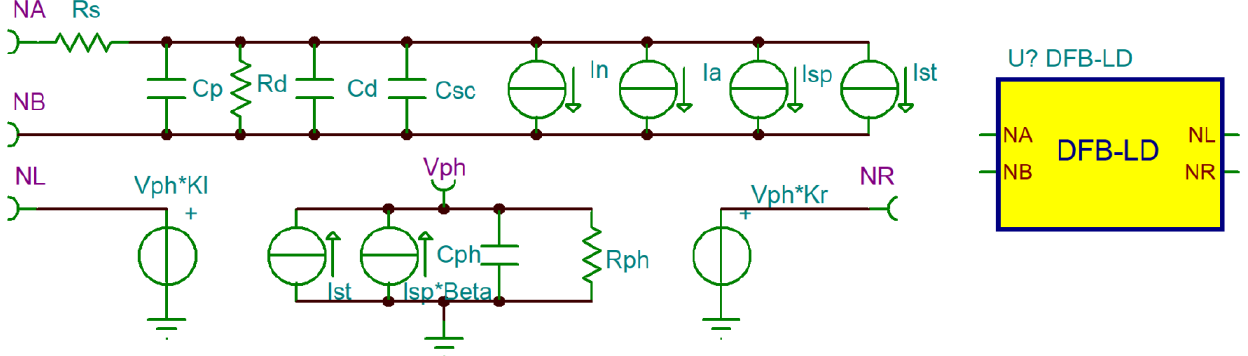
Figure 2. The internal equivalent circuit ( left ) and sub-circuit symbol ( right ) of a DFB-LD. Table 1. Summary of the electric symbols in the equivalent circuit of DFB-LD. Symbols Description